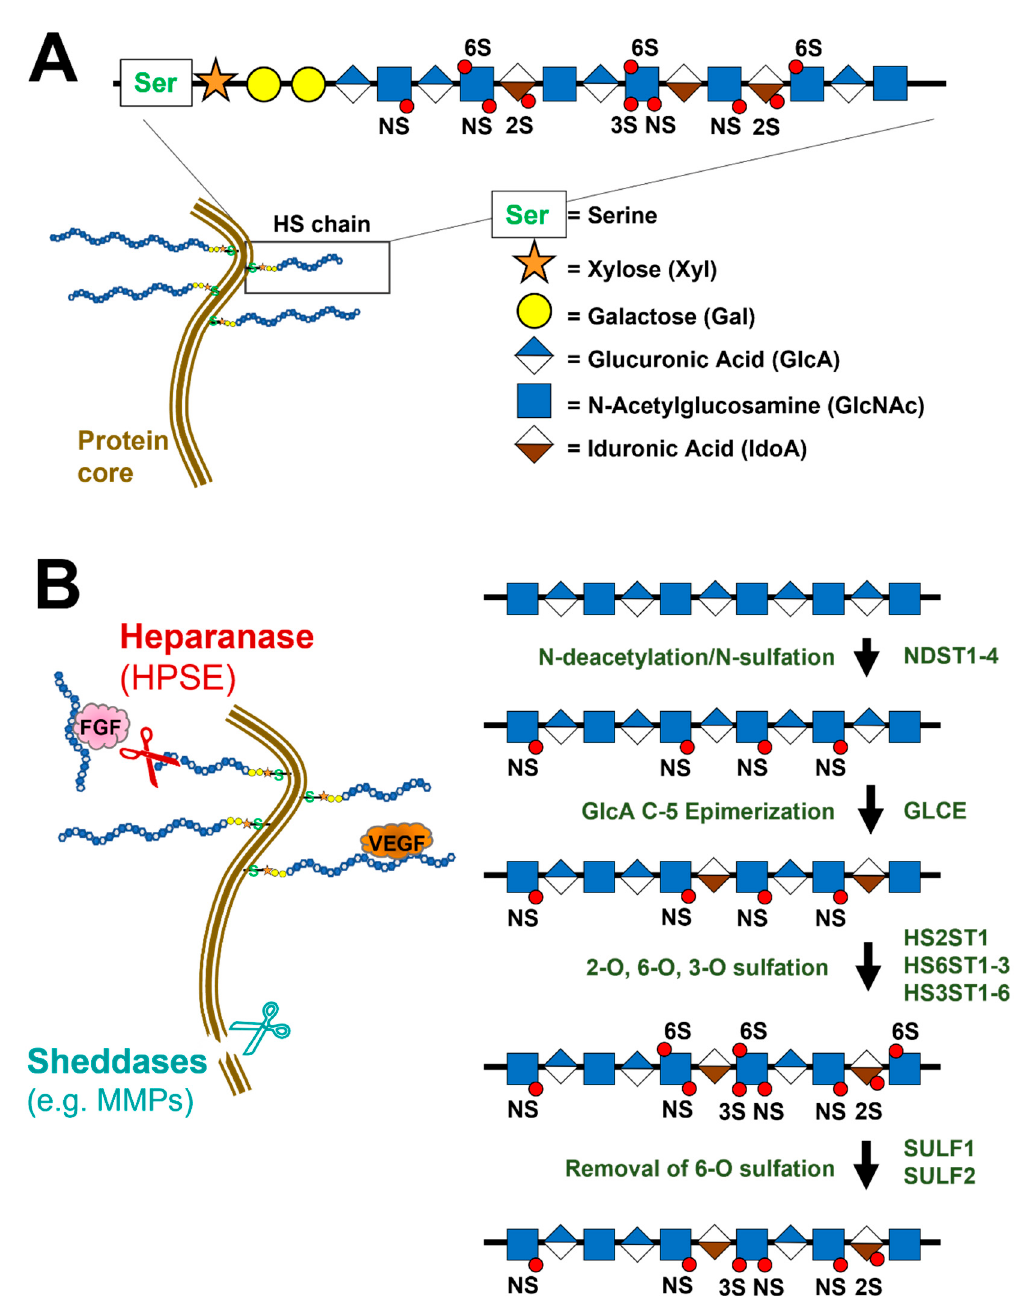
Figure 2. The structure and modifications of heparan sulfate proteoglycans (HSPG). ( A ) The general structure of an HSPG made up of a protein core and branched polysaccharide chains. ( B ) Examples of HSPG modifications such as sulfation patterns as well as remodeling by cleavage of the polysaccharide chains by heparinase or cleavage of the protein core by sheddases. N-sulfation (NS); heparan sulfate (HS); N-deacetylase/N-sulfotransferase (NDST); glucuronic acid epimerase (GLCE); O-sulfotransferases (HS2ST1, HS3ST, HS6ST); endosulfotransferases (SULF1, SULF2); heparanase (HPSE); matrix metalloproteinase (MMP).